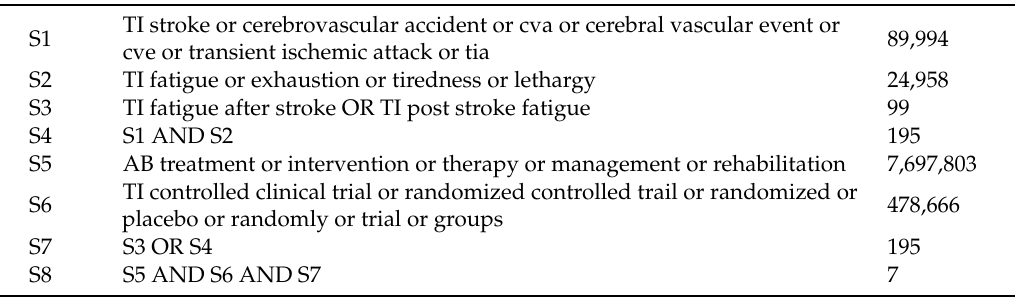
Figure A1. Inconsistency test. Table A1. MEDLINE search terms.